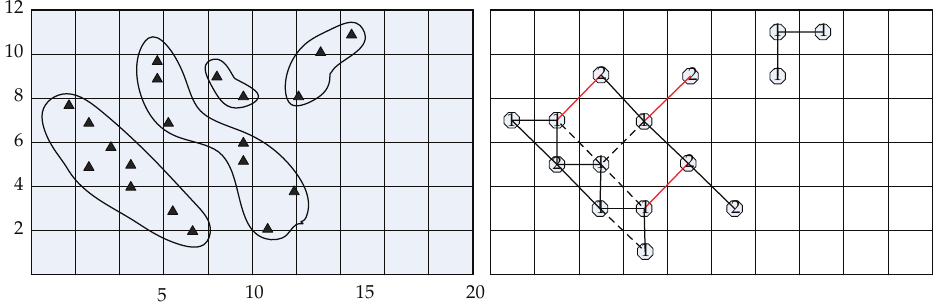
Figure 9: Data with di ff erent grid (cid:5) interval 2 (cid:6) . Parameters p 0 (cid:8) 1 and ω 0 (cid:8)